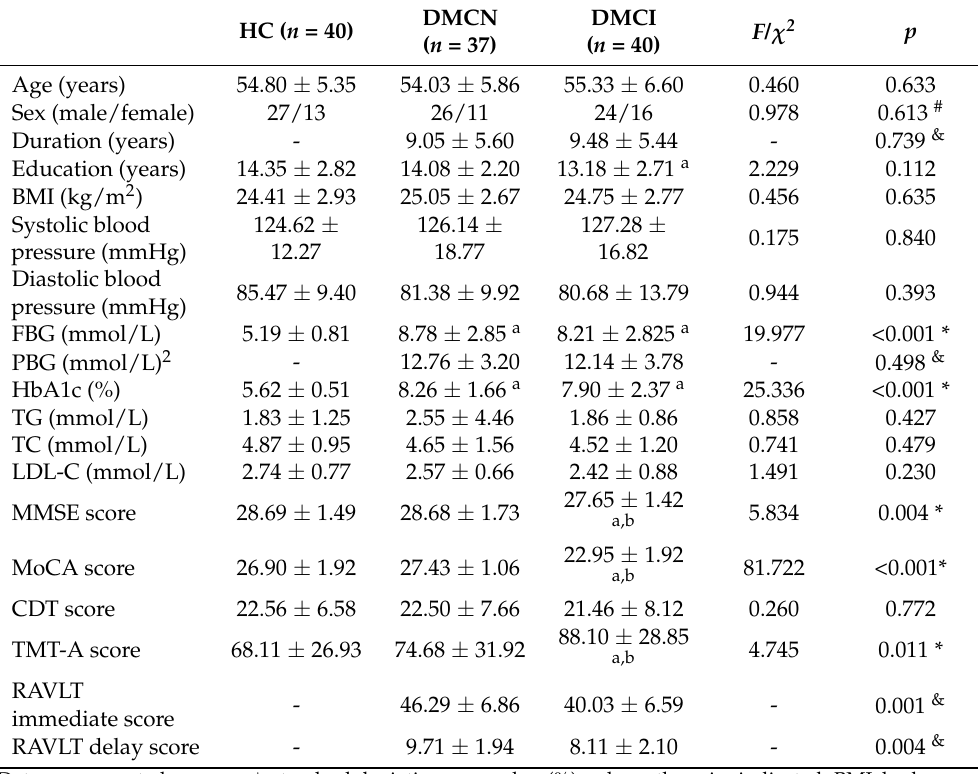
Table 1. Demographic, clinical, and neuropsychological data of T2DM patients and healthy controls.